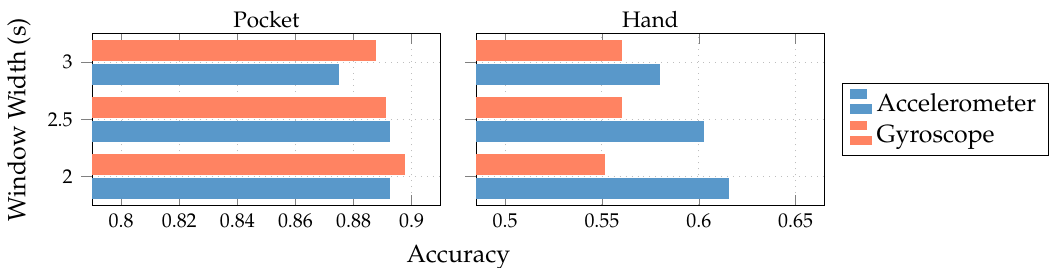
Figure 12. Comparison between classification accuracies when using accelerometer and gyroscope in isolation using a PCA with 5 remaining